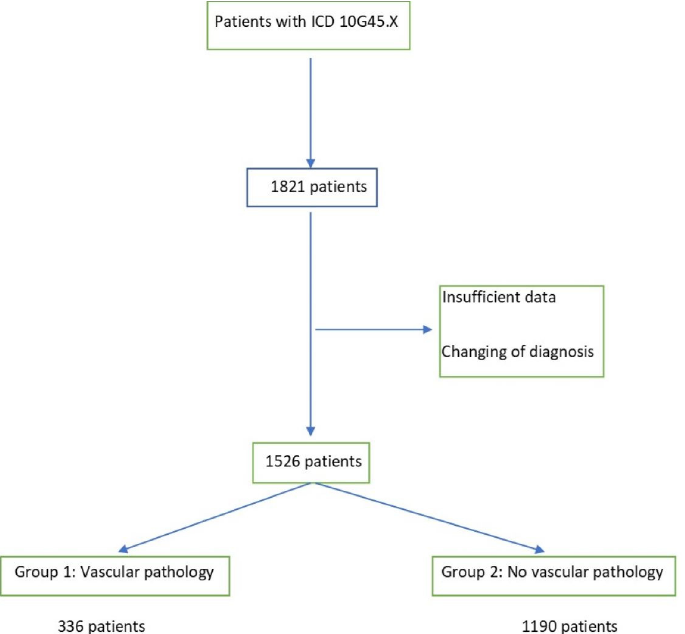
Figure 1. Inclusion flow chart (ICD International Statistical Classification of Diseases and Related Health Problems). Table 1. Characteristics of patients with and without relevant vascular pathology in terms of gender, age, previous illnesses, risk factors, anamnesis, and medication. (NIHSS National Institutes of Health Stroke Scale; DOAK Direct Oral Anticoagulation; TIA Transient Ischaemic Attack; ABCD Age, Blood pressure, Clinical features, Duration of TIA, and presence of Diabetes) Major Pathology n = 336 (22%)